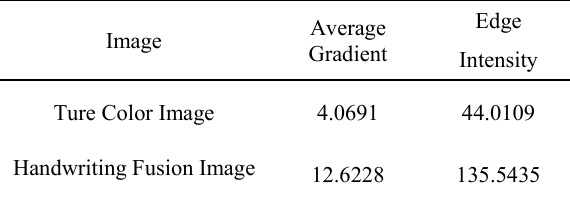
Table 2. Comparison of information between ture color image and handwritting fusion image